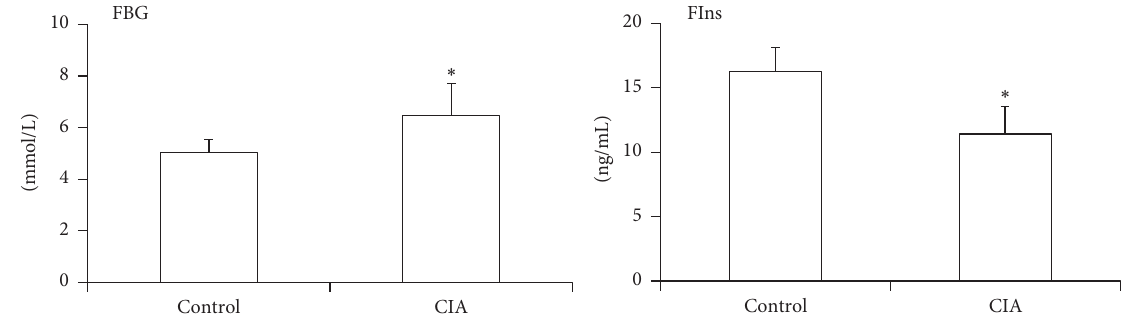
Figure 2: Glucose metabolism dysfunction in CIA rats. Blood samples were collected from the intraocular adjoined veins of the rats on day 17 after initial immunization from CIA rats and control rats. FBG and FIns in sera of both groups were determined as described in the Materials and Methods. The data are presented as mean ± SD ( 𝑛 = 6 – 8 /group) and are representative of three independent experiments. ∗ 𝑝 < 0.05